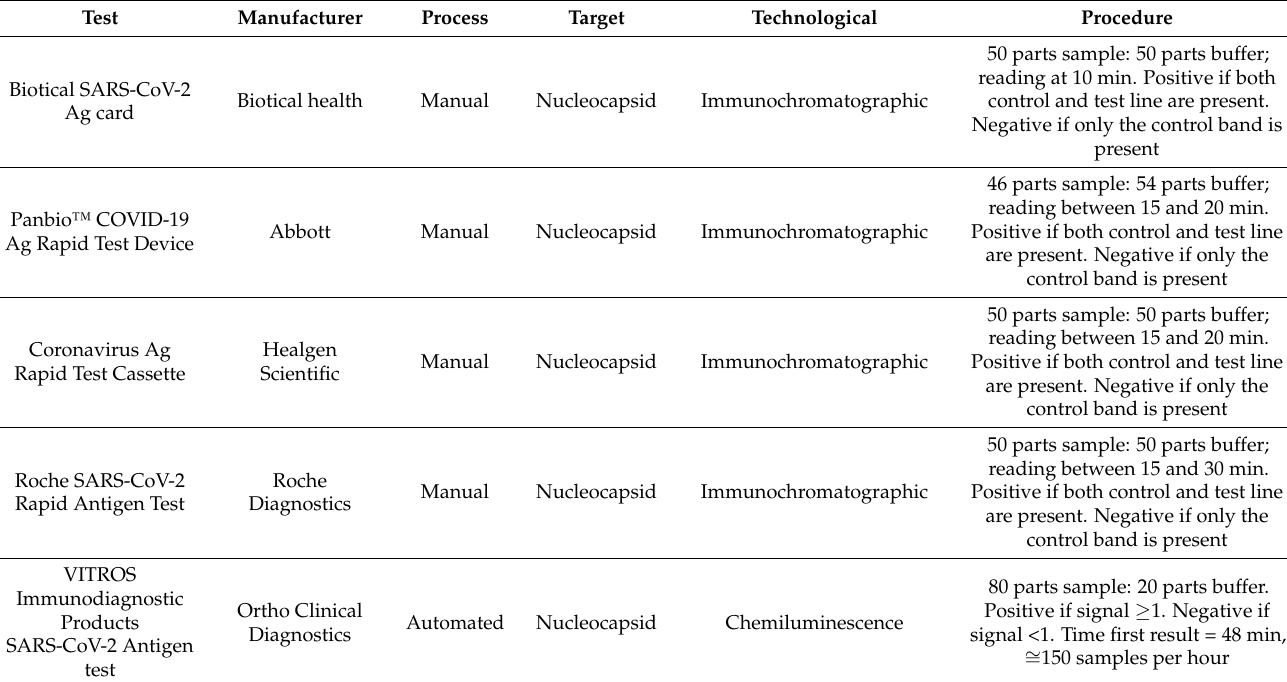
Table 1. Characteristics of antigenic tests used in this